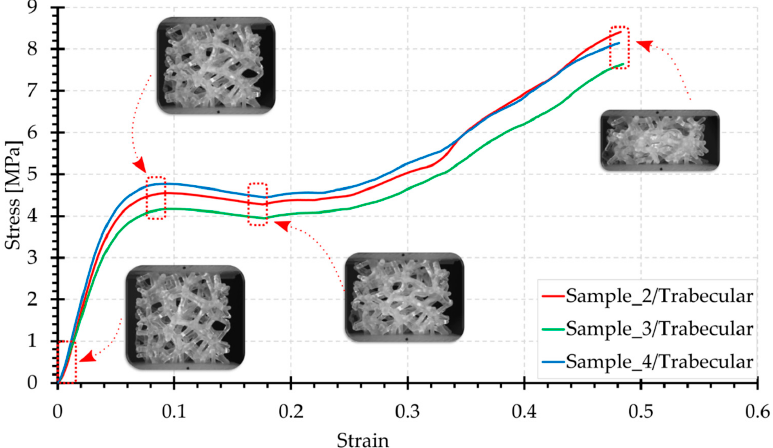
Figure 10. Compression curve for the Trabecular structure with photographs of the topology at selected test phases.